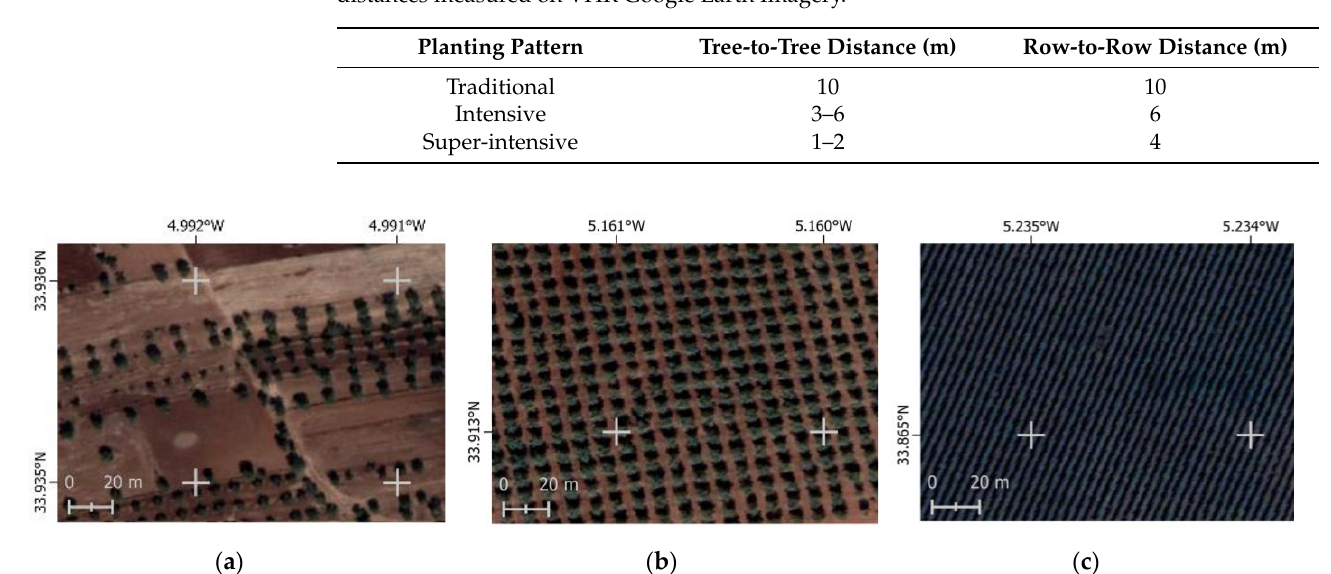
Figure 5. Bi-temporal photointerpretation of deciduous orchards. ( a ) Google Earth Image from February and ( b ) Google Earth Image from October, showing the visible difference in tree crown size and greening. Table 3. Definition of subcategories for olive plantations based on tree-to-tree and row-to-row distances measured on VHR Google Earth Imagery.